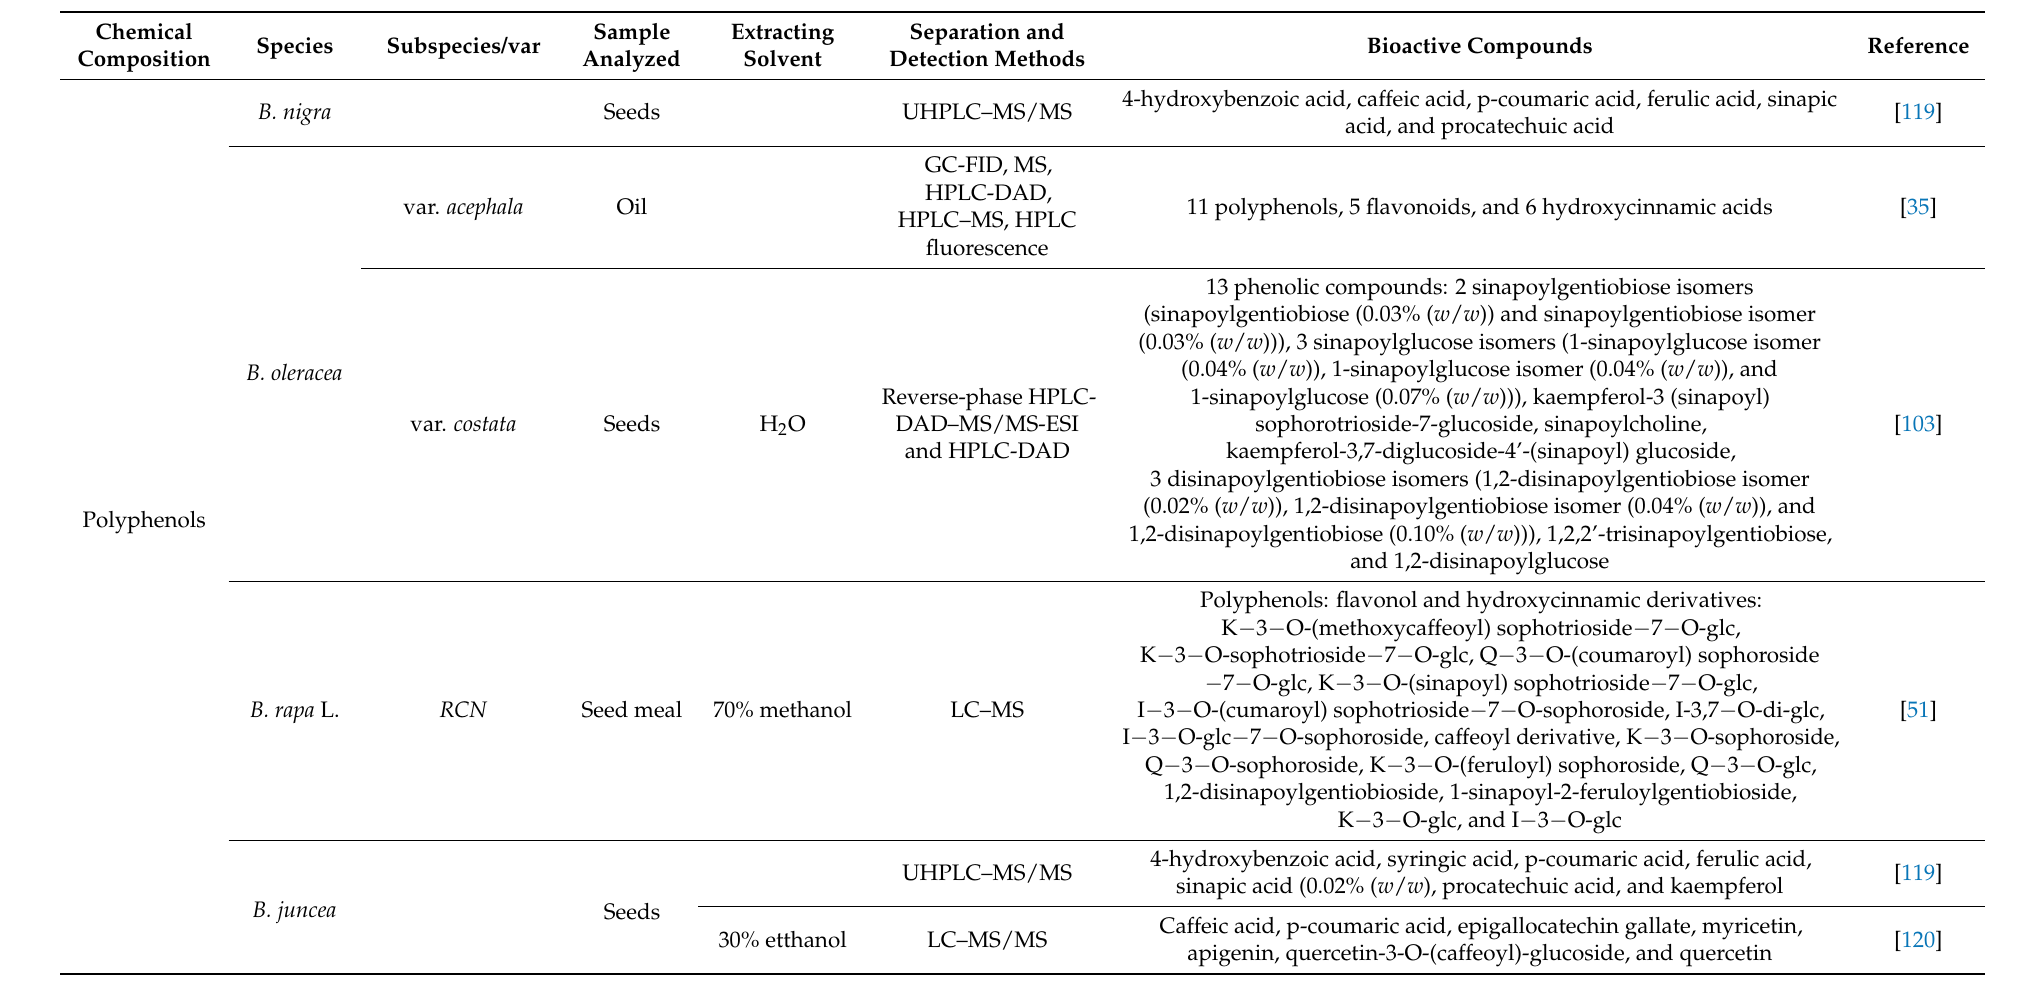
Table 4. Bioactive compounds identified from Brassica seed/derivative extracts and essential oil using different analytical techniques